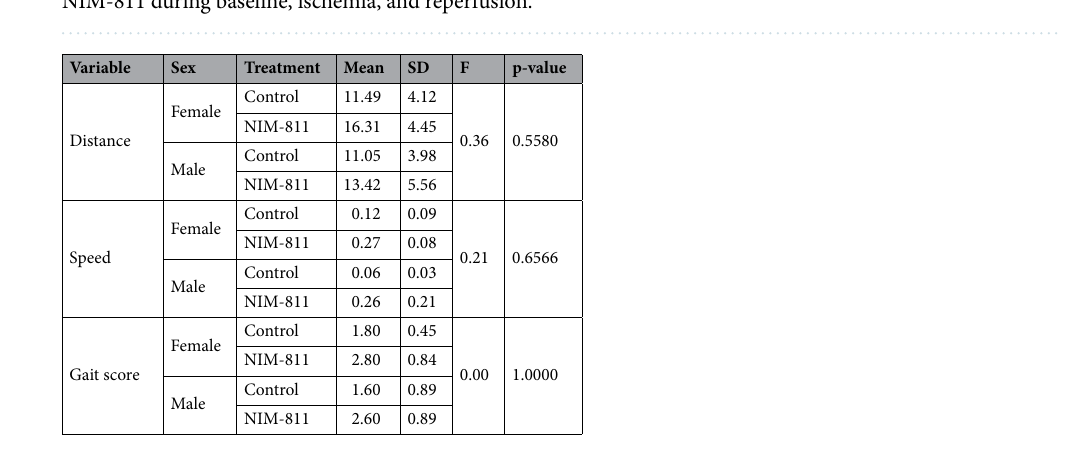
Table 1. Descriptive statistics of gait measures by sex and treatment group and the two-factor ANOVA F-test for the sex by treatment